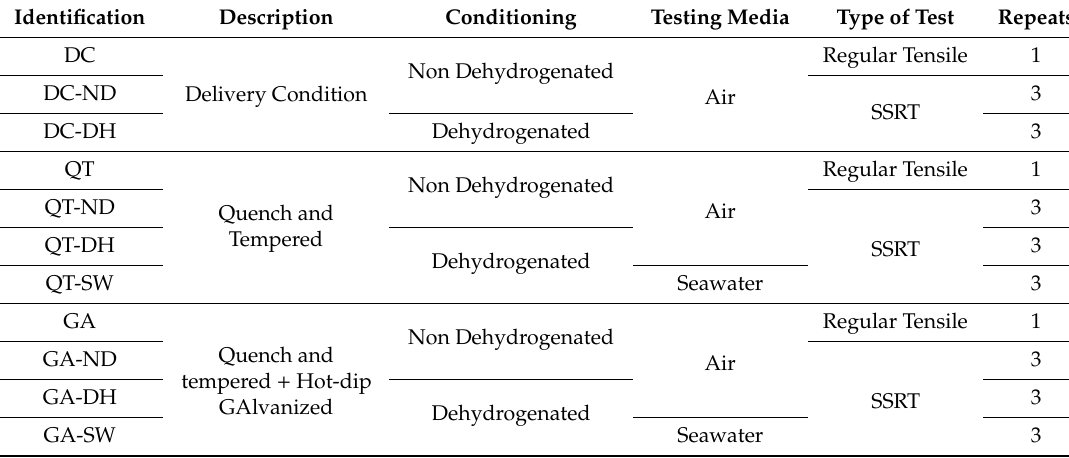
Table 3. Summary of the tensile testing battery.